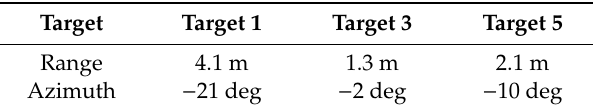
Table 5. Target positions in Experiment 2.